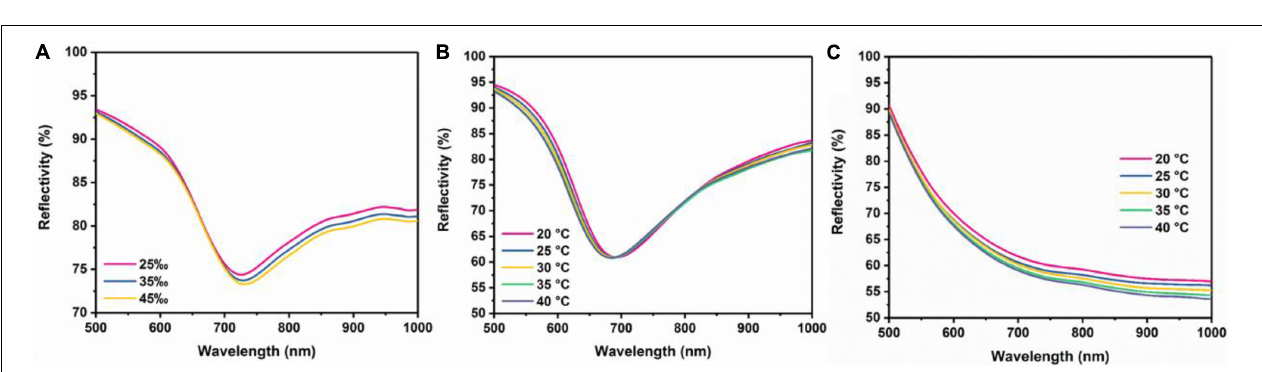
FIGURE 4 | Reflectivity spectra of the FOSPR sensor in water with different (A) salinities and (B) temperatures and (C) reflectivity spectra of the FOSPR sensor in oil with different temperatures.